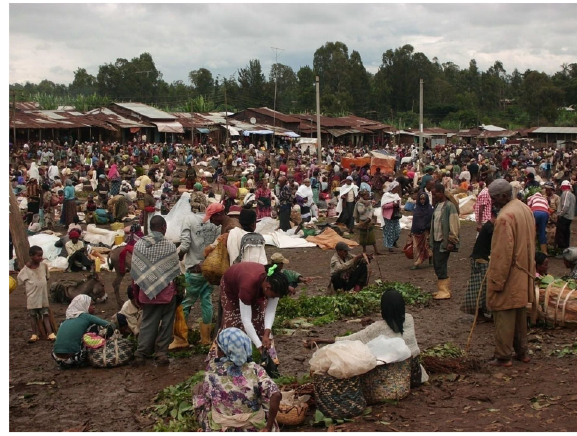
Fig. 3 Partial view of